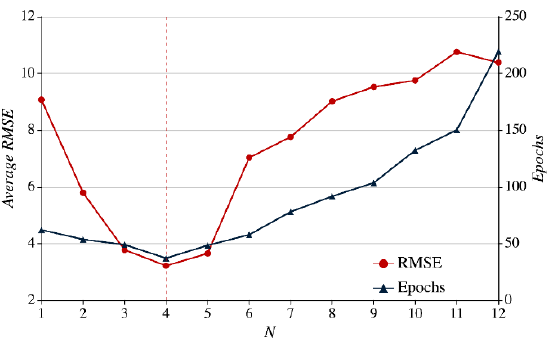
Figure 14. Impact on SAM error and convergence epochs with different number of sequences.